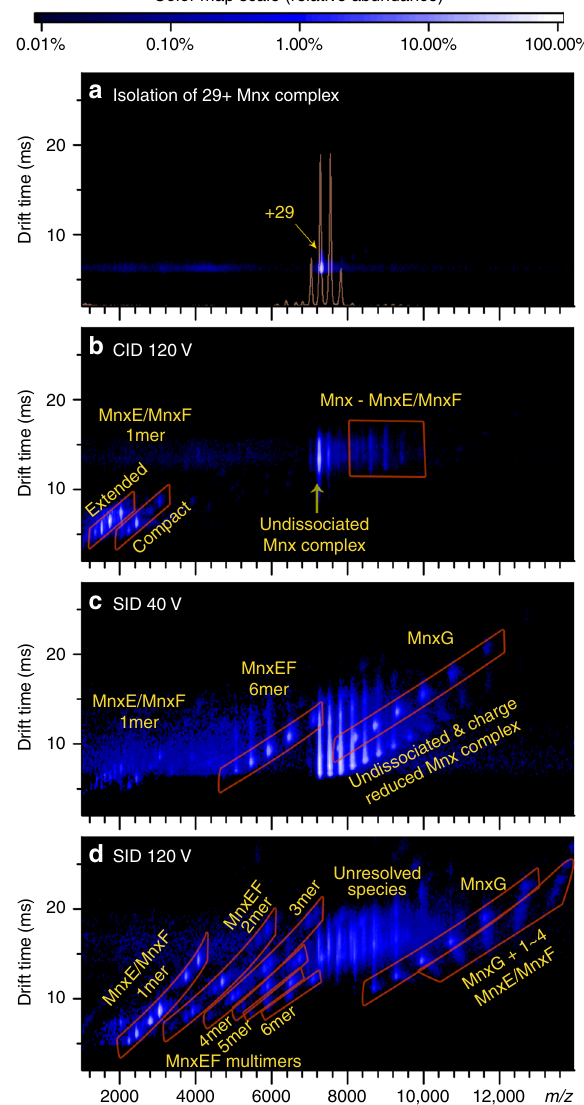
Fig. 3 Dissecting Mnx in the gas phase for characterization of quaternary structure. Ion mobility mass spectra of a the isolated 29+ Mnx complex, b CID at 120V, c SID at a low collision voltage of 40V, and d SID at a high- collision voltage of 120V. The color of the spots represents the relative abundance, with the color scale above the fi gure. Figure 1a was overlaid in a as the light orange trace to better display the single charge state of Mnx that was isolated. When the Mnx complex was activated in the collision cell pressurized with argon in CID b , monomers of MnxE and MnxF were released (around m/z 2000), leaving behind the stripped complex (Mnx complex losing one MnxE or one MnxF, around m/z 9000). Upon activation of SID at 40V c , the complex dissociates into MnxEF hexamer (mostly E 3 F 3 ) and MnxG (highlighted in red parallelograms), suggesting that the Mnx complex is comprised of a MnxEF hexamer attached to a MnxG monomer. At higher activation energy d , more extensive dissociation of the MnxEF hexamer and Mnx complex into smaller subcomplexes can be